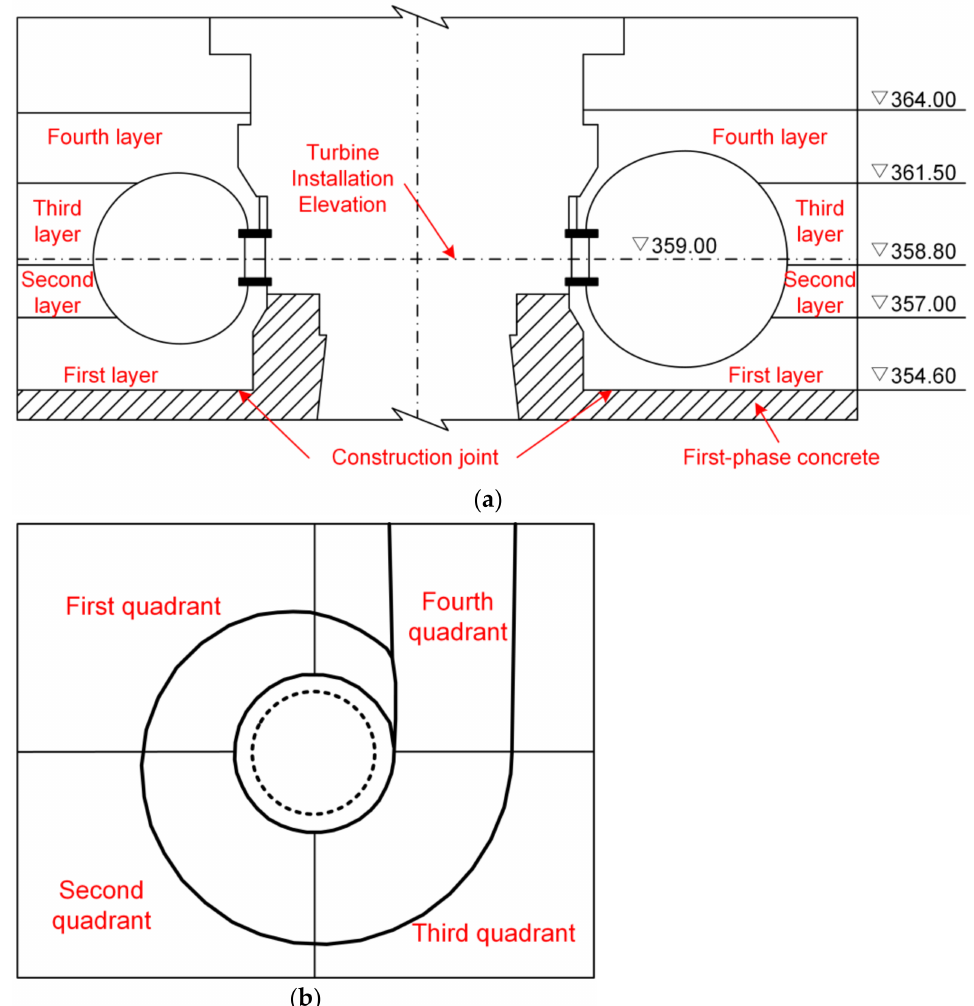
Figure 5. The concreting process of the SCS: ( a ) four concreting layers; ( b ) four concreting